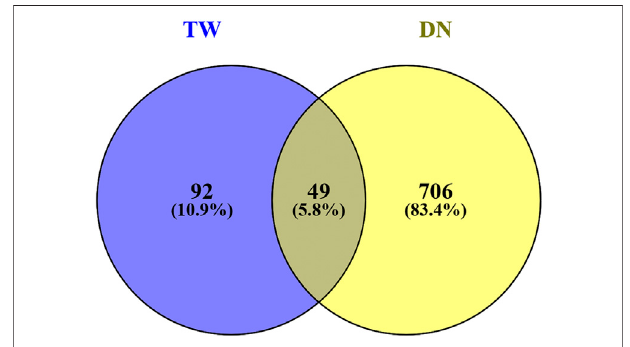
FIGURE 3 | Venn diagram of drugs and disease